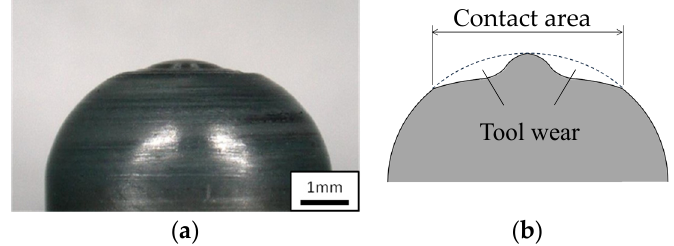
Figure 5. Tool tip shape after processing: ( a ) Side view of R = 3 mm tool; and ( b ) Schematic of tool wear.